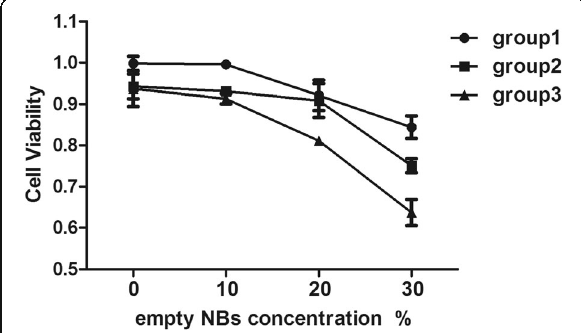
Fig. 6 In vitro cytotoxicity of various NBs concentrations and sound intensity in MCF-7